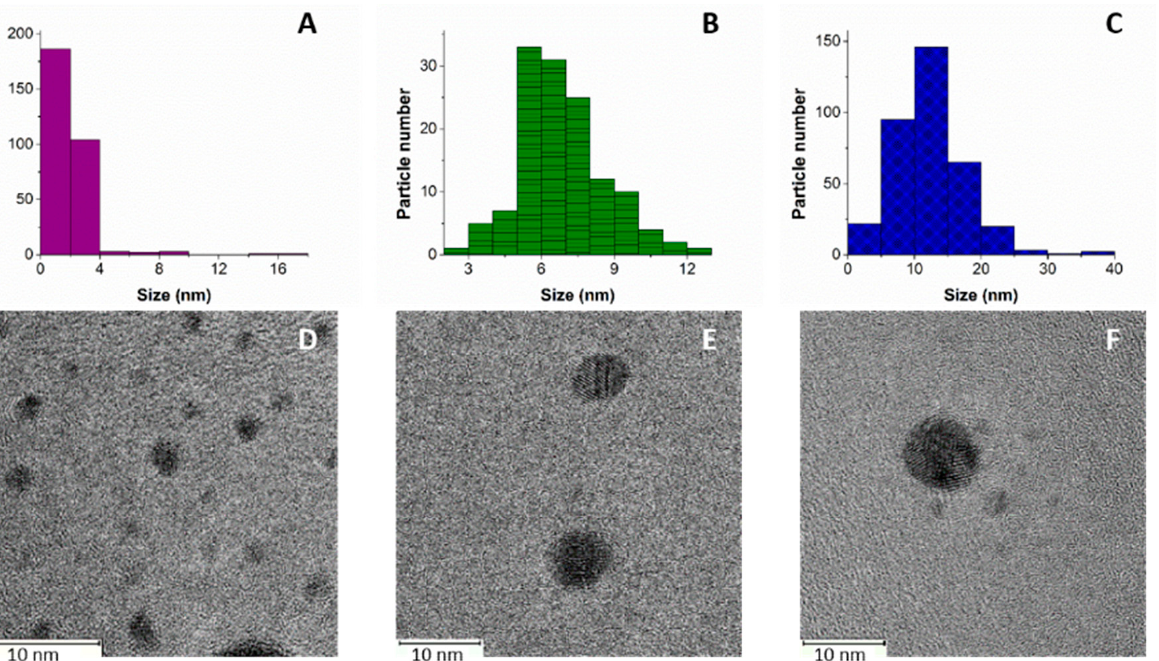
Figure 1. Silver nanoparticles show size-dependent silver nitrate concentration. AgNPs were visu- alized using size distribution and HRTEM images: ( A , D ) 0.055 M AgNO 3 , ( B , E ) 0.167 M AgNO 3 , and ( C , F ) 0.500 M AgNO 3 .